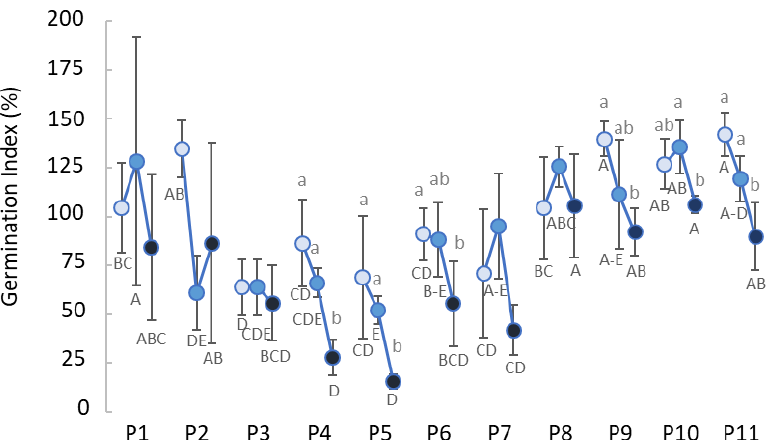
Figure 3. Germination index of cress seeds exposed to compost water extracts (P1 to P11) at 50 (dark blue), 16.6 (medium blue) and 5 g L −1 (light blue). Lower and uppercase lettering indicate significant differences ( p ≤ 0.05), according to the Least Significant Difference post hoc test, among the concentration within the same sample and the sample within the same concentration, respectively.